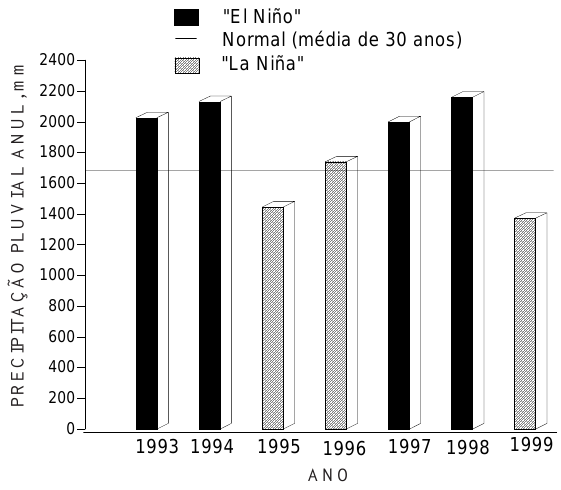
Figura 1. Precipitação pluvial anual ocorrida durante os fenômenos “El Niño” e “La Niña”, no período de 1993-1999 e precipitação normal (média de 30